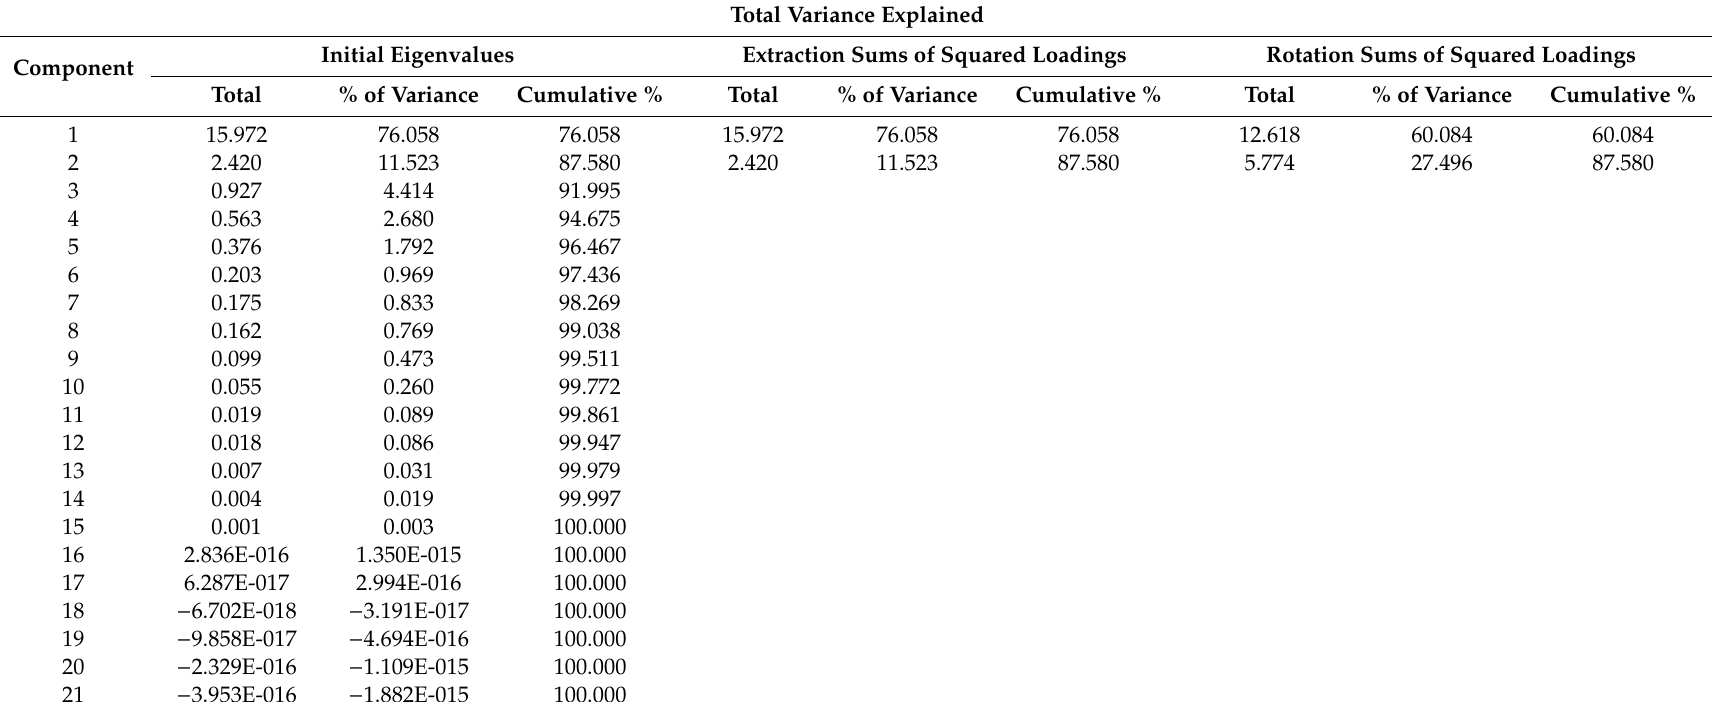
Table 3. Eigenvalues and variance contribution rates of the principal